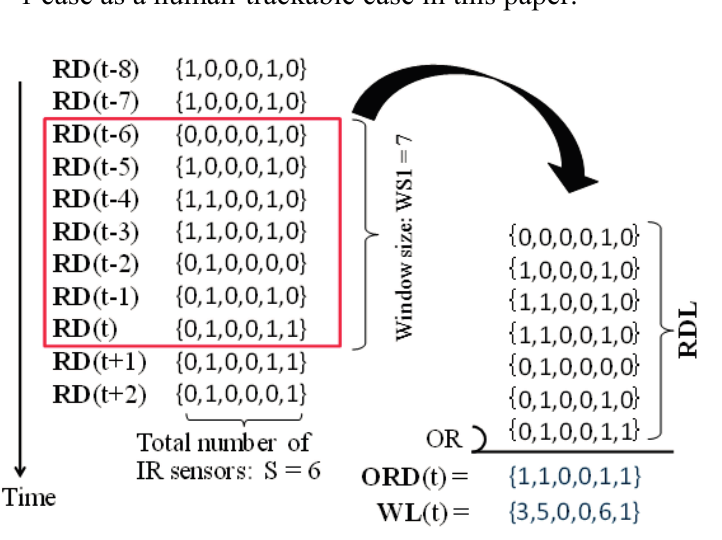
Figure 2. Example of sensed raw data